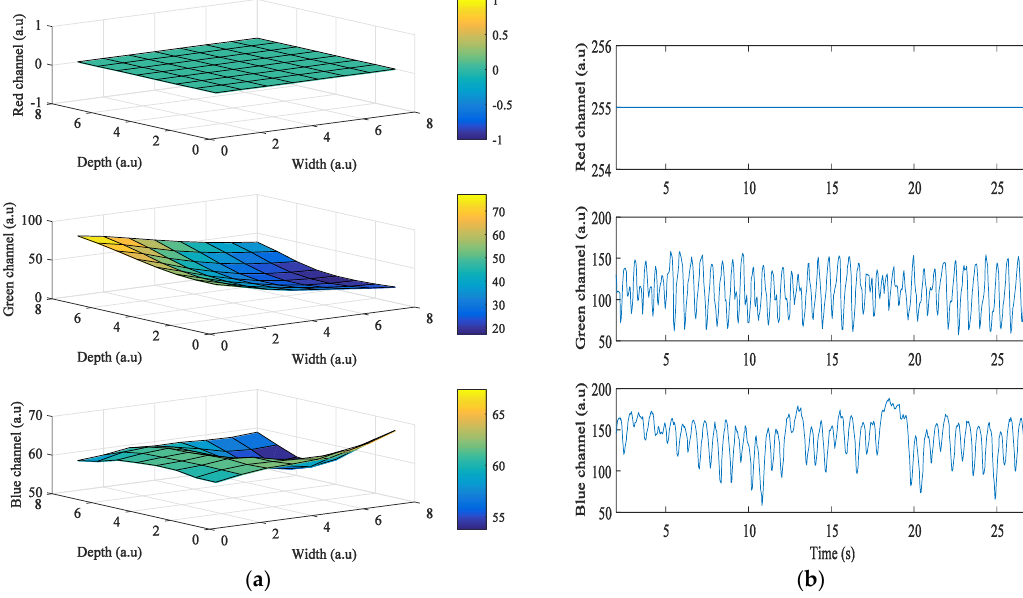
Figure 6. Example of quality analysis of PPG signals obtained from a subject using the Galaxy S6 with horizontal movements: ( a ) intensity change distribution; ( b ) intensity of PPG signal.